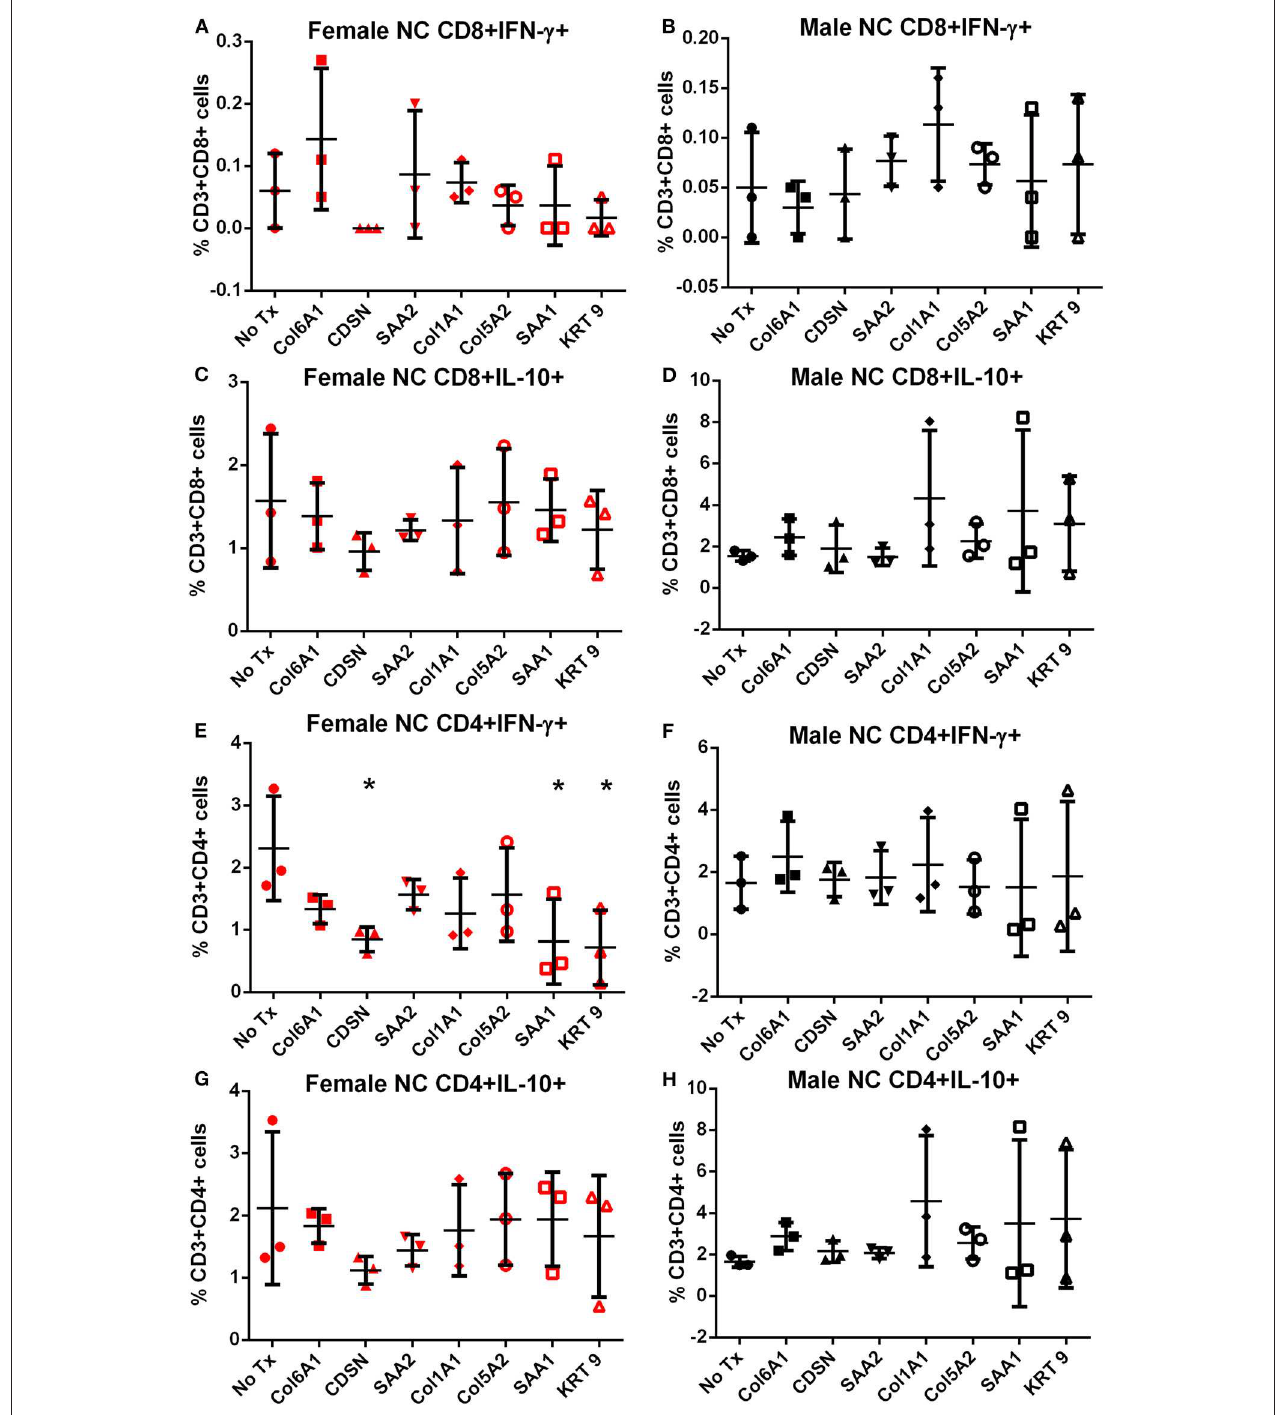
FIGURE 2 | Intracellular cytokine staining of splenocytes from mice fed with normal chow. Splenocytes from female (A,C,E,G) or male (B,D,F,H) apoE–/– mice fed normal chow (NC) stimulated for 6h with mouse homologs of self-peptides selected from patient immune peptidome and stained for intracellular IFN- γ and IL-10. N = 3 each; * P < 0.05 compared to No Tx. Gating scheme in Figure S1